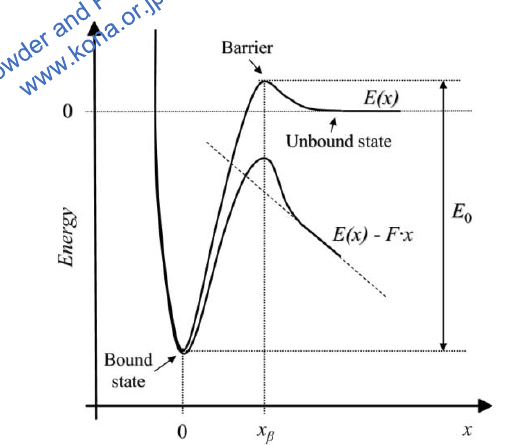
Fig. 5 Schematic of the interaction potential of a bond with an activation barrier. The external force ap- plied by the spring F tilts the potential and low- ers the activation barrier E . 0